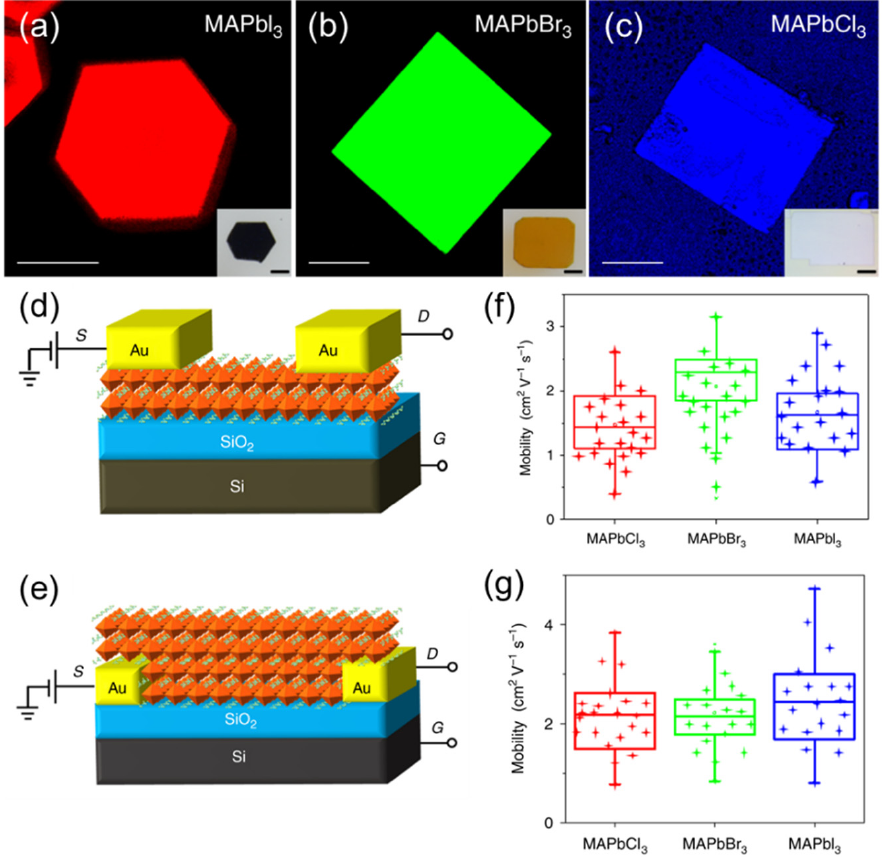
Figure 7. Fluorescence microscopy images of ( a ) MAPbI 3 , ( b ) MAPbBr 3 and ( c ) MAPbCl 3 single crystals (excited with a pulsed lasers with wavelengths of 450, 473 and 405 nm, respectively) with a scale bar of 100 µ m. Inset: optical images of the corresponding single crystals with a scale bar of 200 µ m. Schematic of the ( d ) bottom gate top contact (BGTC) and ( e ) bottom gate bottom contact (BGBC) device with the tested perovskite single crystal as semiconductor layer and the hole mobility distribution of (20 devices) each halide perovskite under ( f ) BGTC and ( g ) BGBC device structure [68], Copyright 2018 Springer